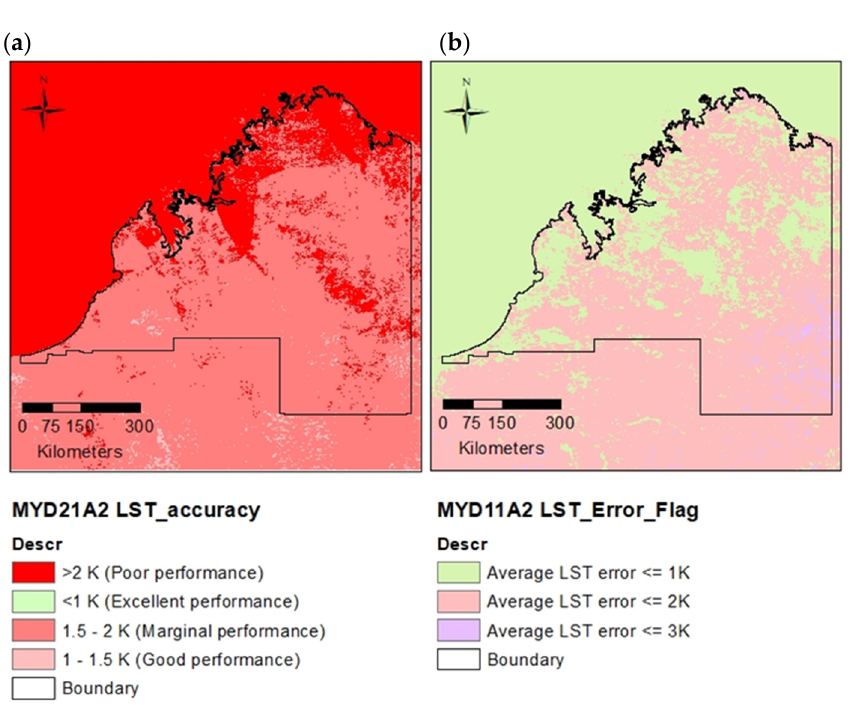
Figure 14. Image 2019009 , Kimberley emissivity error comparison: ( a ) MYD21A2 and ( b ) MYD11A2.